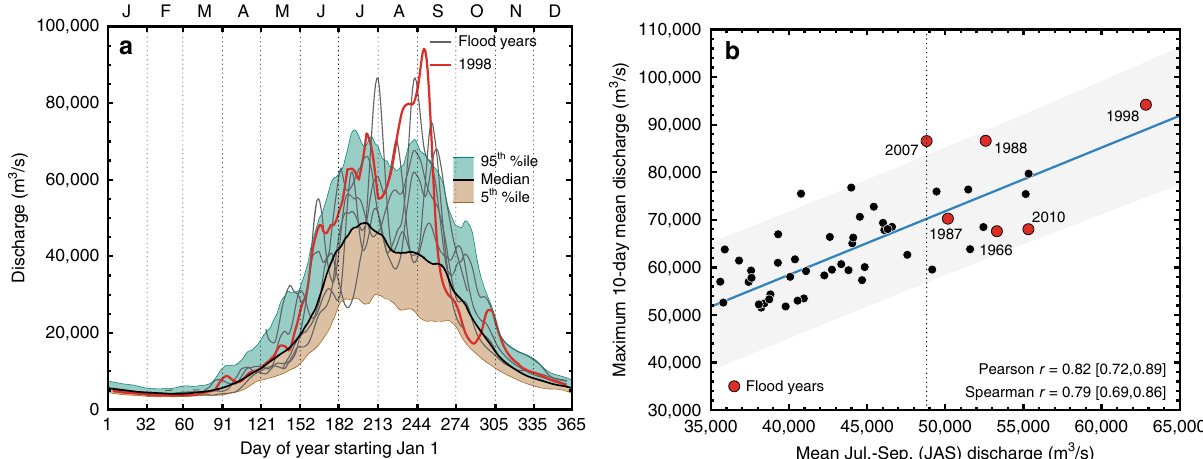
Fig. 2 Discharge characteristics of the Brahmaputra at Bahadurabad, Bangladesh between 1956 and 2011 C.E. a Annual 10-day mean discharge hydrograph. The brown and green envelopes represent the 5th, 50th, and 95th percentiles of 10-day mean discharge, respectively. The 5 grey and 1 red line represent 10-day mean discharge during instrumental period fl ood years in 1966, 1987, 1988, 1998 (in red), 2007, and 2010 C.E. b Scatter plot of mean JAS discharge against maximum 10-day mean daily discharge. The six fl ood years are highlighted in red. The vertical dashed line highlights mean JAS discharge in 2007 (48,800 m 3 /s), the lowest discharge of the 6 instrumental period documented fl ood years. The bootstrapped Pearson and Spearman rank correlations are calculated as the median and 5th and 95th percentile of 1000 draws with replacement. The grey uncertainty envelope (±2 σ ) is derived from the best- fi t linear regression (blue